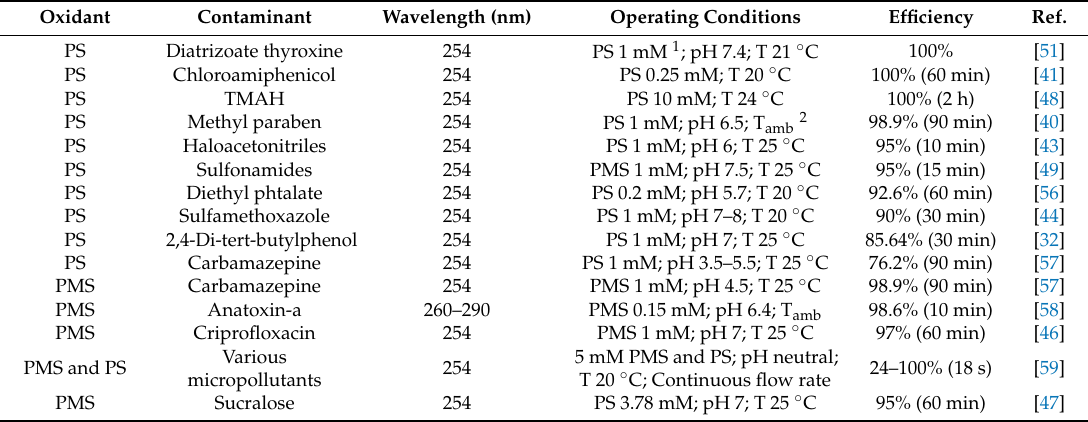
Table 3. Micropollutant removal by ultraviolet (UV) radiation-mediated PMS and PS activation. Oxidant Contaminant Wavelength (nm) Operating Conditions Efficiency